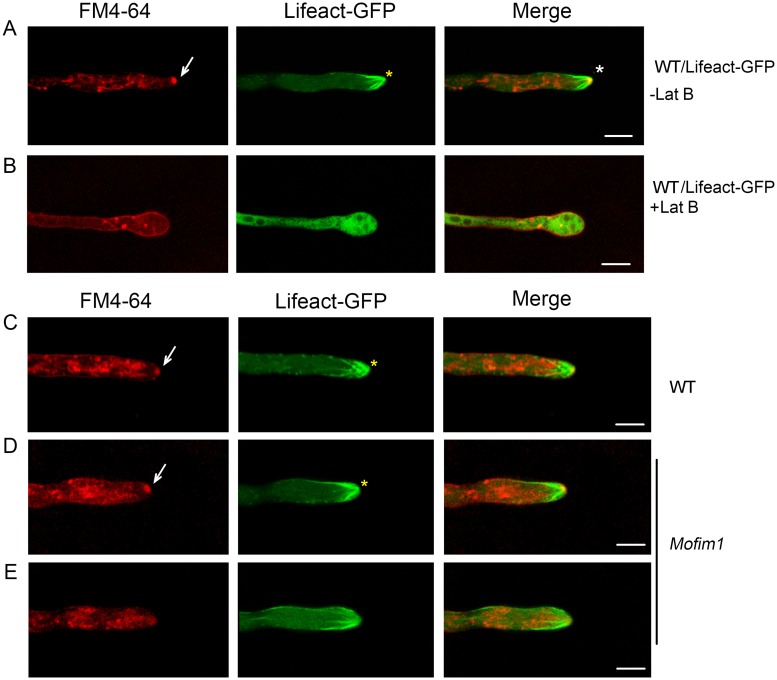
Defects in actin cytoskeleton-mediated endocytosis in Mofim1.(A) Colocalization of the actin cytoskeleton and FM4-64-labeled Spk. The arrowhead indicates FM4-64-labeled Spk. The asterisk indicates the fluorescence merge of FM4-64 and actin at the Spk. Bar = 5 μm. (B) Colocalization of Lifeact-GFP and FM4-64 in hyphae pretreated with Lat B for 30 min. Bar = 5 μm. (C–E) Representative images showing FM4-64 stained hyphae of WT (C) or the Mofim1 mutant with (D) or without a Spk (E). The arrowheads indicate FM4-64-labeled Spk and the yellow asterisks indicate actin at the Spk. Bars = 5 μm.